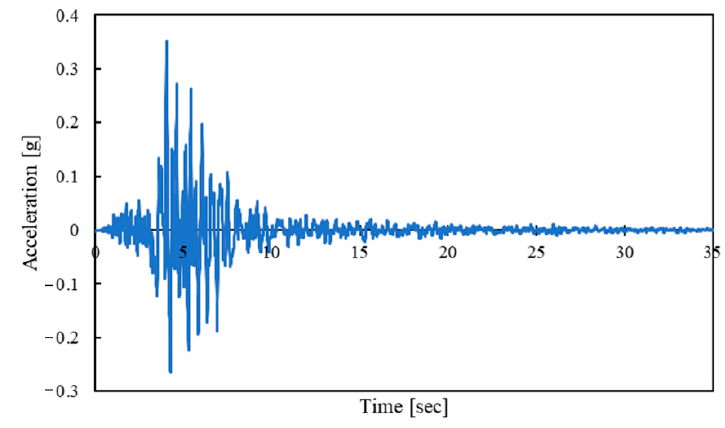
Figure 6. Acceleration time history of the Friuli earthquake.